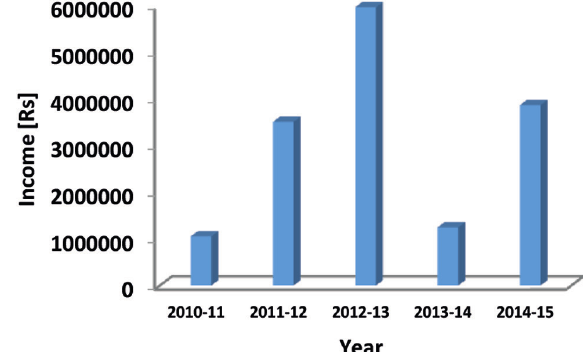
Fig. 5. Year wise fish production of the beel.